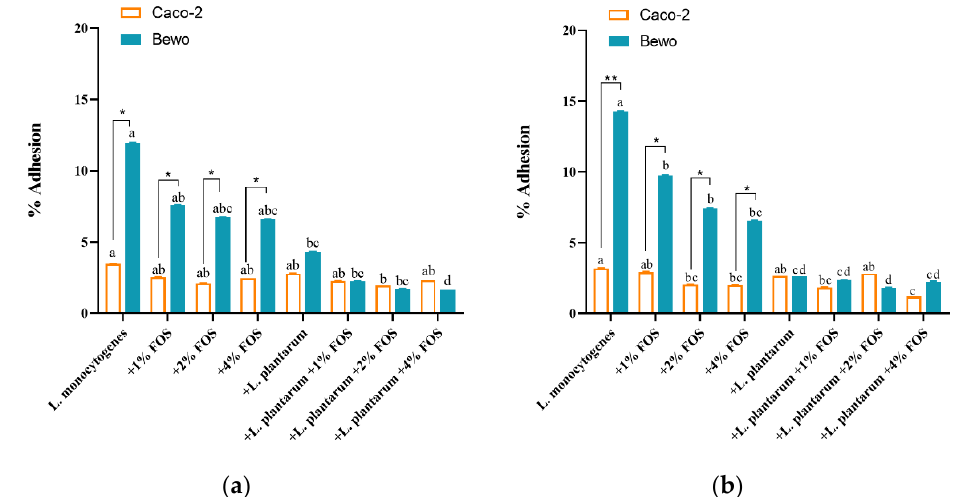
Figure 3. Adhesion to Caco-2 cells and BeWo cells of L. monocytogenes , grown in BHI at 10 °C for 12 days ( a ) or at 25 °C for 40 h ( b ) in different treatment groups: (1) the untreated, (2) 1% ( w / v ) FOS, (3) 2% ( w / v ) FOS, (4) 4% ( w / v ) FOS, (5) L. plantarum supplementation, (6) L. plantarum + 1% ( w / v ) FOS, (7) L. plantarum + 2% ( w / v ) FOS, (8) L. plantarum + 4% ( w / v ) FOS groups. Values are mean ± SD ( n = 6). Asterisks indicate significant differences between the invasion rate to Caco-2 and BeWo cells, * p < 0.05, ** p < 0.01. Different lowercase letters (a, b, c, and d) indicate significant differences ( p < 0.05) among treatments for each cell